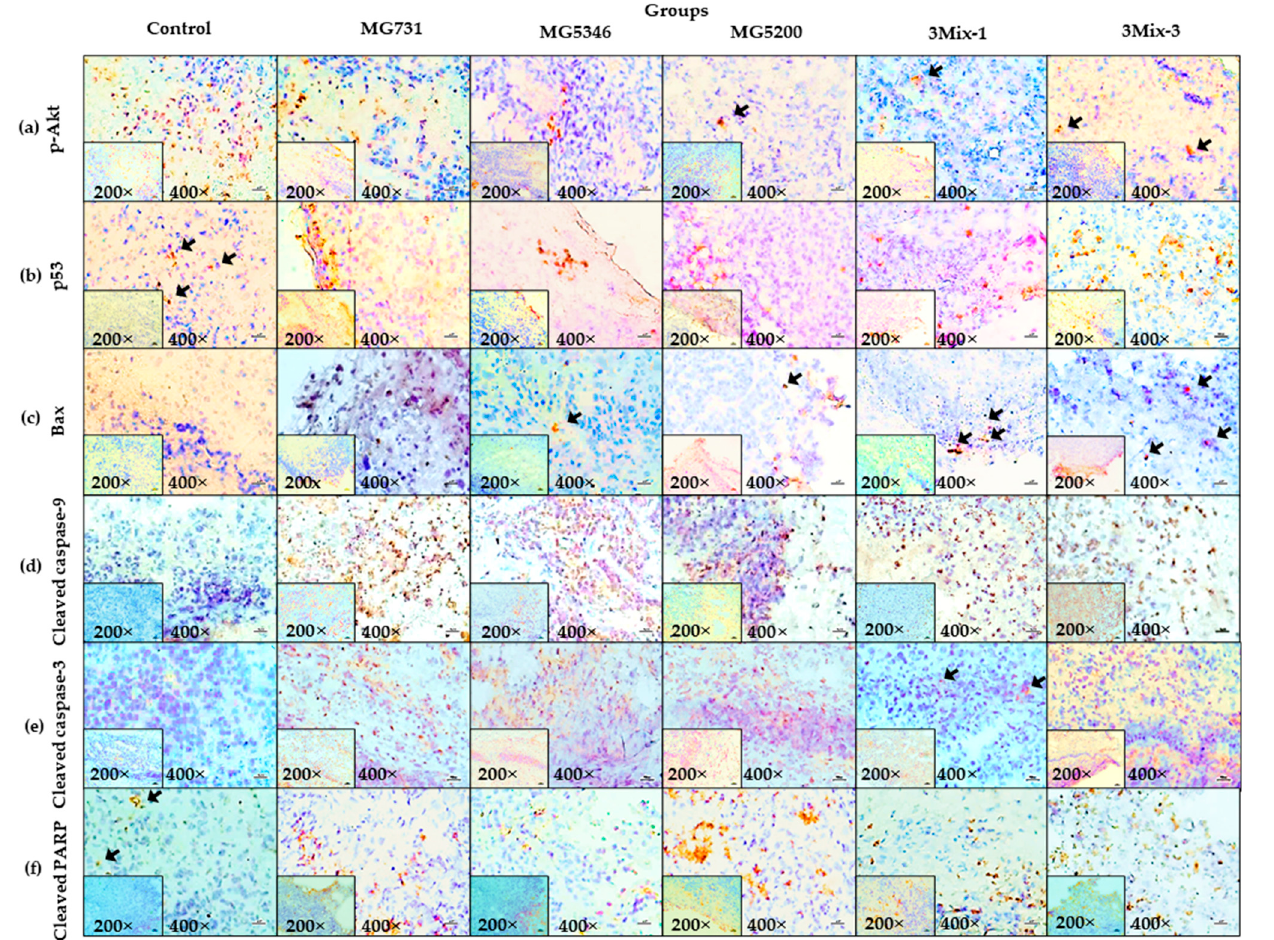
Figure 6. Immunohistochemistry analysis of the tumor tissues. After 19 days of heat-killed single or mixed strain treatment, tumor tissues were harvested and stained by ( a ) p-Akt, ( b ) p53, ( c ) Bax, ( d ) cleaved caspase-9, ( e ) cleaved caspase-3, and ( f ) cleaved PARP. The scale bar represents 100 px. Brown dots are expression of p-Akt, p53, Bax, cleaved caspase-9 and -3, PARP. Black arrows indicate the brown dots of IHC (magnification 200× or 400× as indicated).